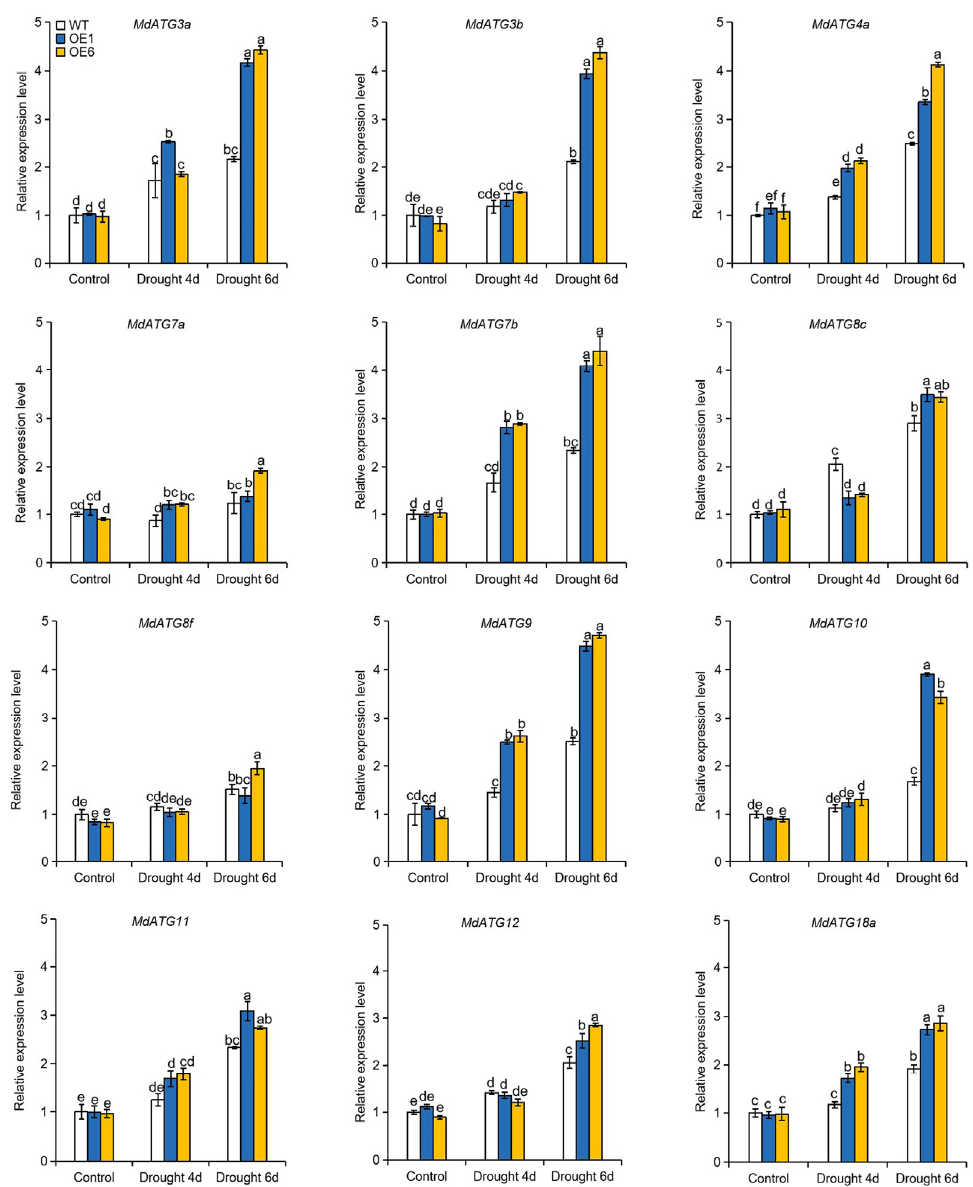
Figure 8. Change in the expression levels of several core apple autophagy-related genes ( MdATGs ) in the leaves of the WT and transgenic plants following drought treatment. The data are presented as means ± SD of three replicates. Values with different letters are significantly different ( p < 0.05, Tukey’s multiple range test).